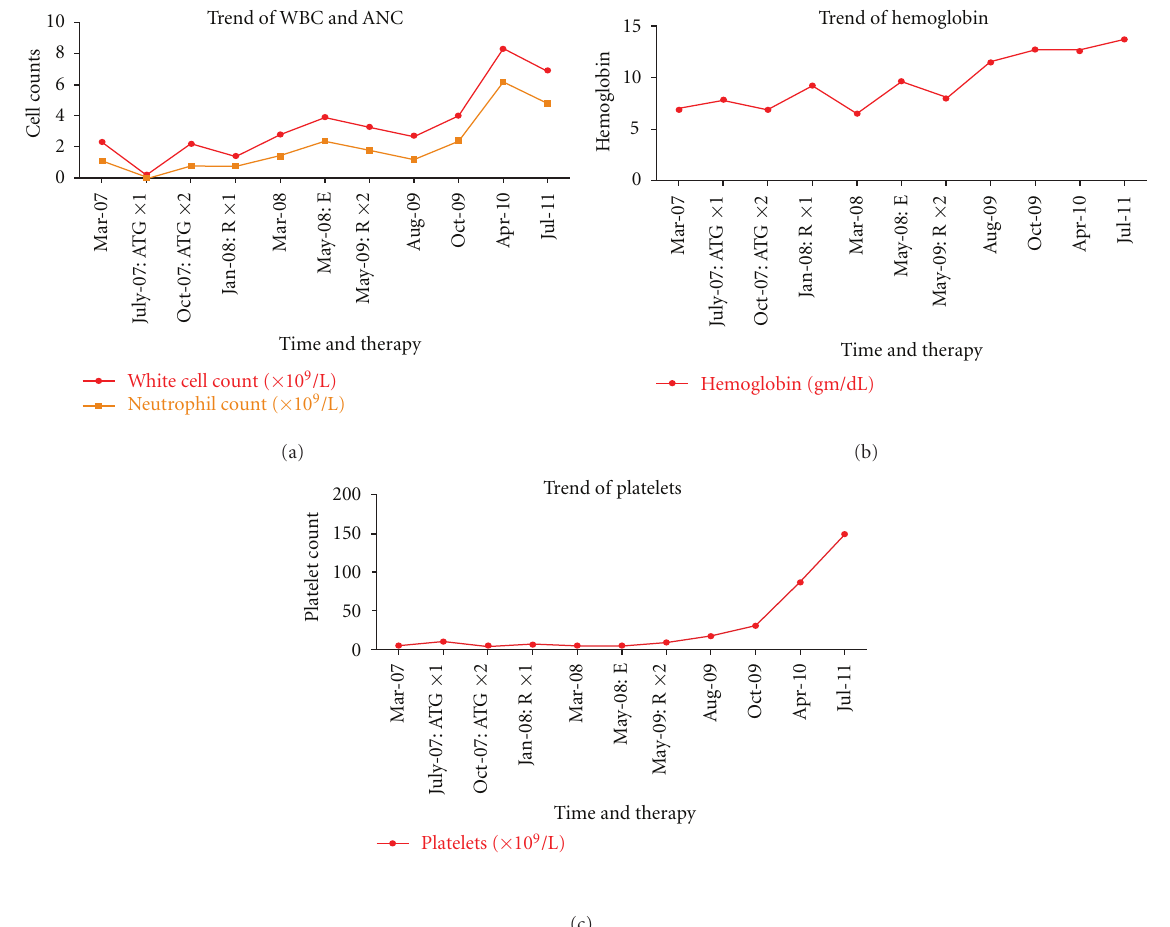
Figure 3: The improvement in blood counts from the time of diagnosis to most recent. (a) white cell and neutrophil counts, (b) describes the hemoglobin trend, and (c) the platelet trend. The x axis is not drawn to scale and shows various time points and therapy administered. ATG: antithymocyte globulin, R: rituximab, and E: